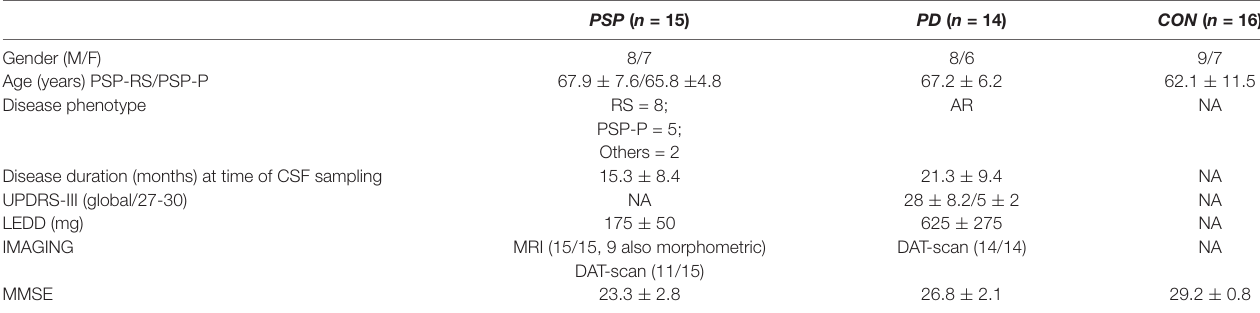
TABLE 2 | Demographic and clinical features of patients with progressive supranuclear palsy (PSP), Parkinson’s Disease (PD), and control.